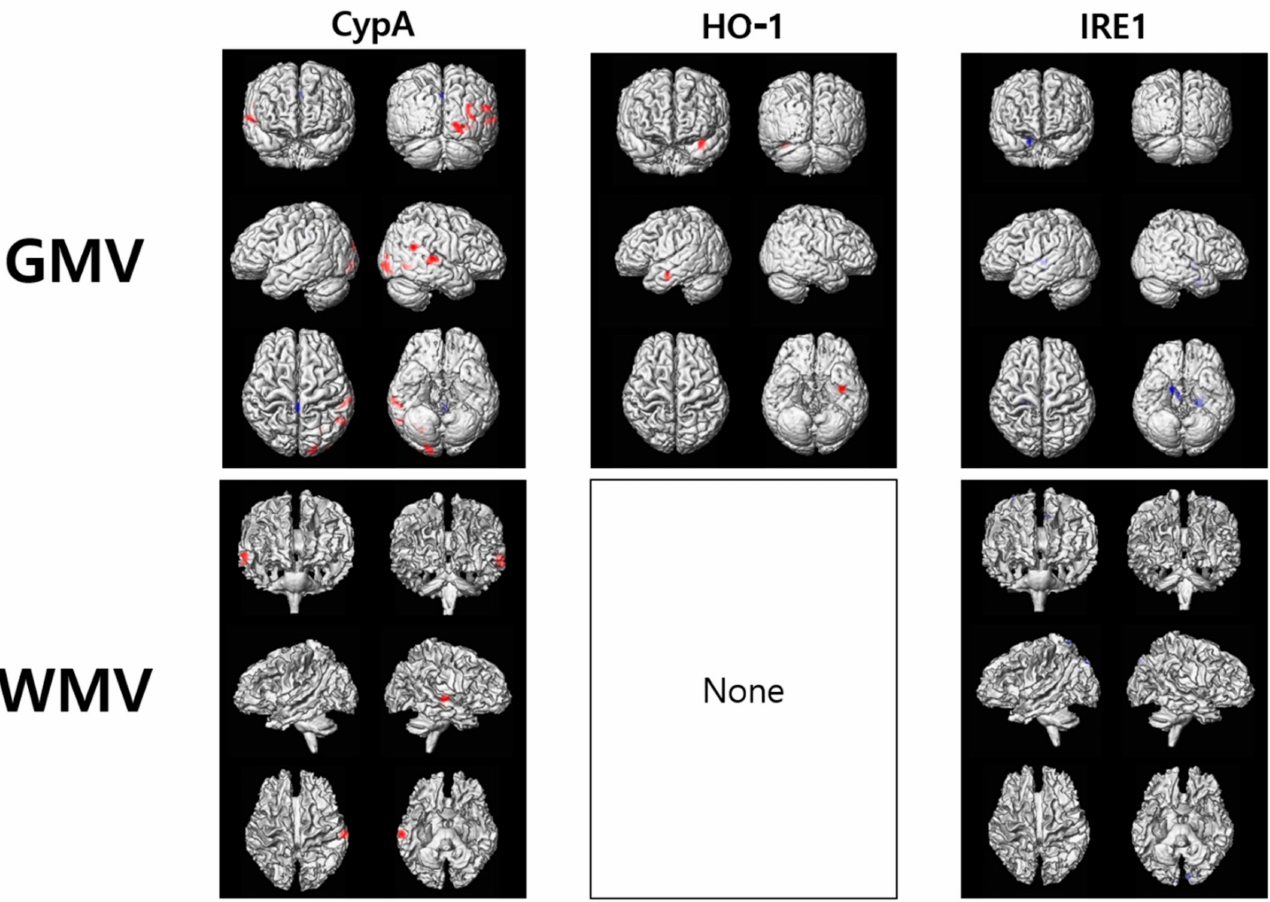
Figure 3. Voxel-based multiple regression analyses between brain tissue volumes and the levels of the CypA, HO-1, and IRE1. CypA, cyclophilin A; HO-1, heme oxygenase-1; IRE1, inositol-requiring enzyme 1. The red and blue colors indicate positive and negative associations,